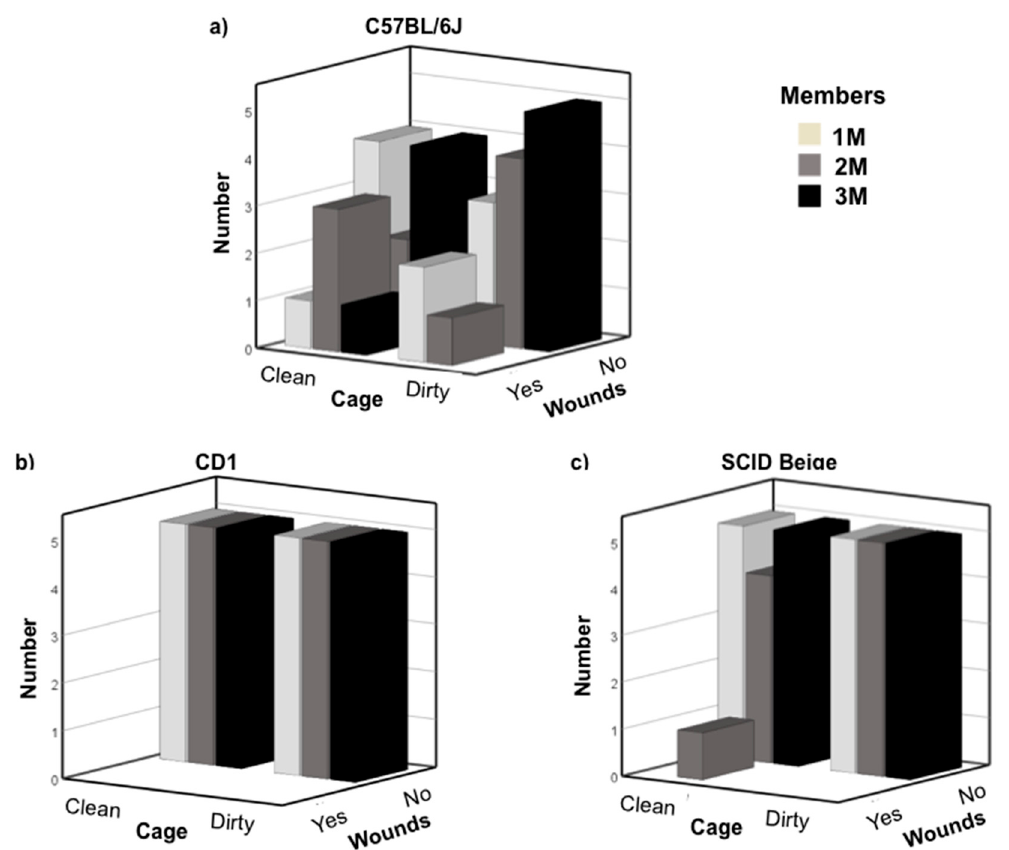
Figure 2. Number of cages in which wound due to fights were observed: ( a ) C57BL/6J, ( b ) CD1, and ( c ) SCID Beige newly weaned mice after grouping with early pubescent male mice. X-axis shows the condition of the cage, clean or dirty. Z-axis shows whether there were or were no wounds due to fights. White bars indicate cages with one member, grey bars two members, and black bar three members’ cages. A total of 30 cages per strain were analyzed—five cages per condition.